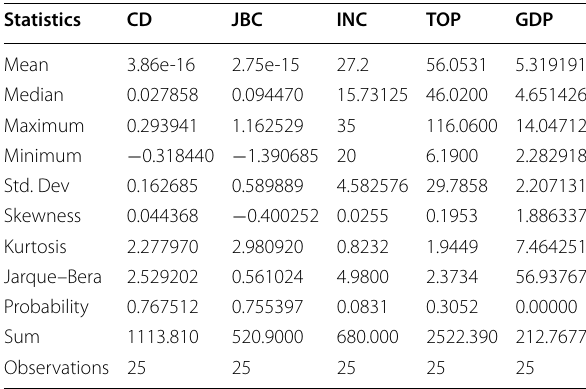
Table 2 Summary statistics of the